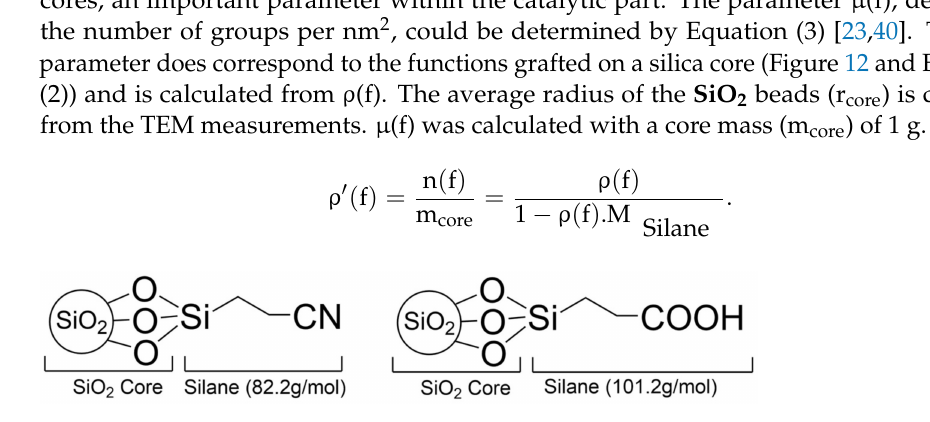
Figure 12. Schematic representation of the silica